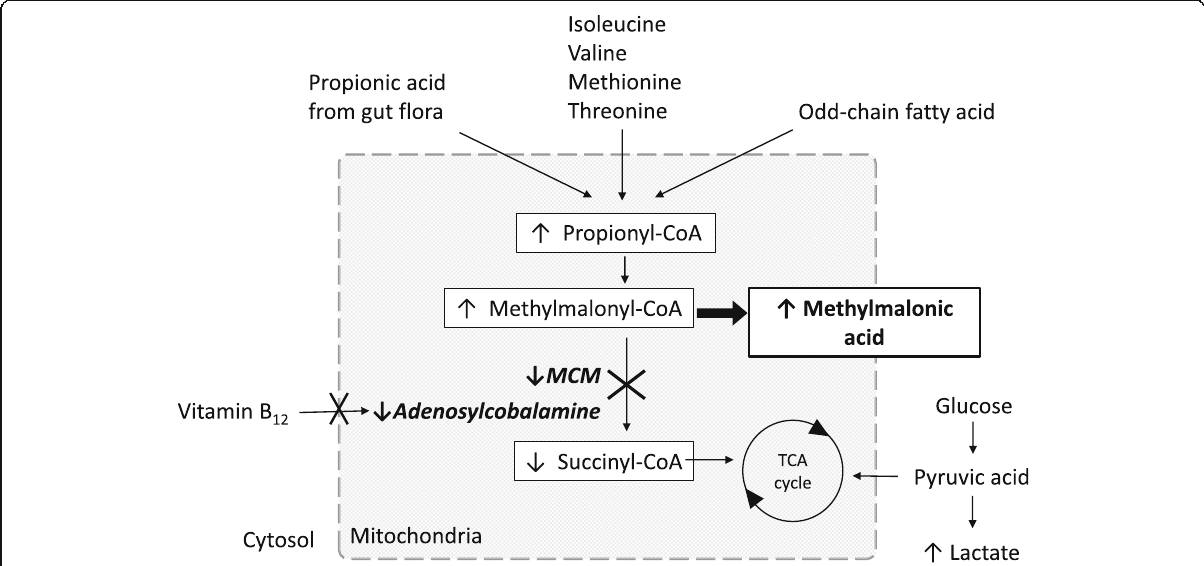
Fig. 1 Metabolic pathway of methylmalonic acidemia. Methylmalonic acid (MMA) accumulates systemically because of intracellular